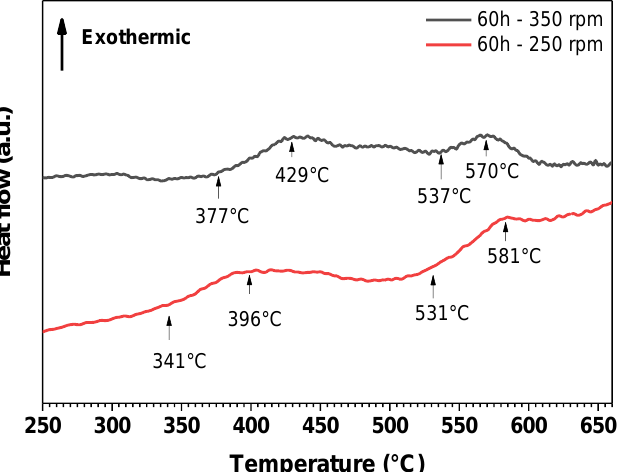
Figure 6. DSC curves of Al 82 Fe 14 Ni 4 powders milled at 250 and 350 rpm for 60 h using a heating rate of 20 K/min.